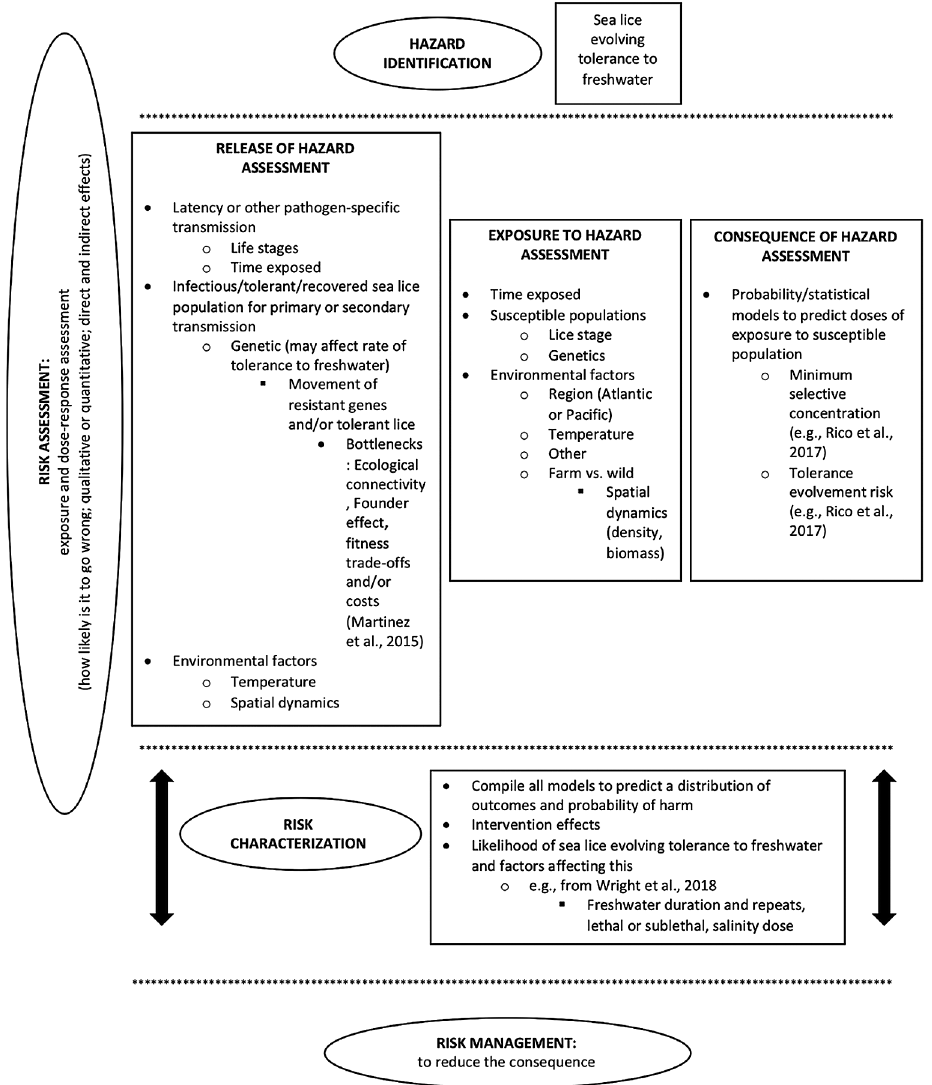
Fig. 4. Suggested risk analysis framework incorporating quantitative methods (Brouwer et al. 2018, Kristoffersen et al. 2018) and additional risk and quantitative examples for characterizing the risk of sea lice evolving tolerance to freshwater. Ovals represent the OIE risk model